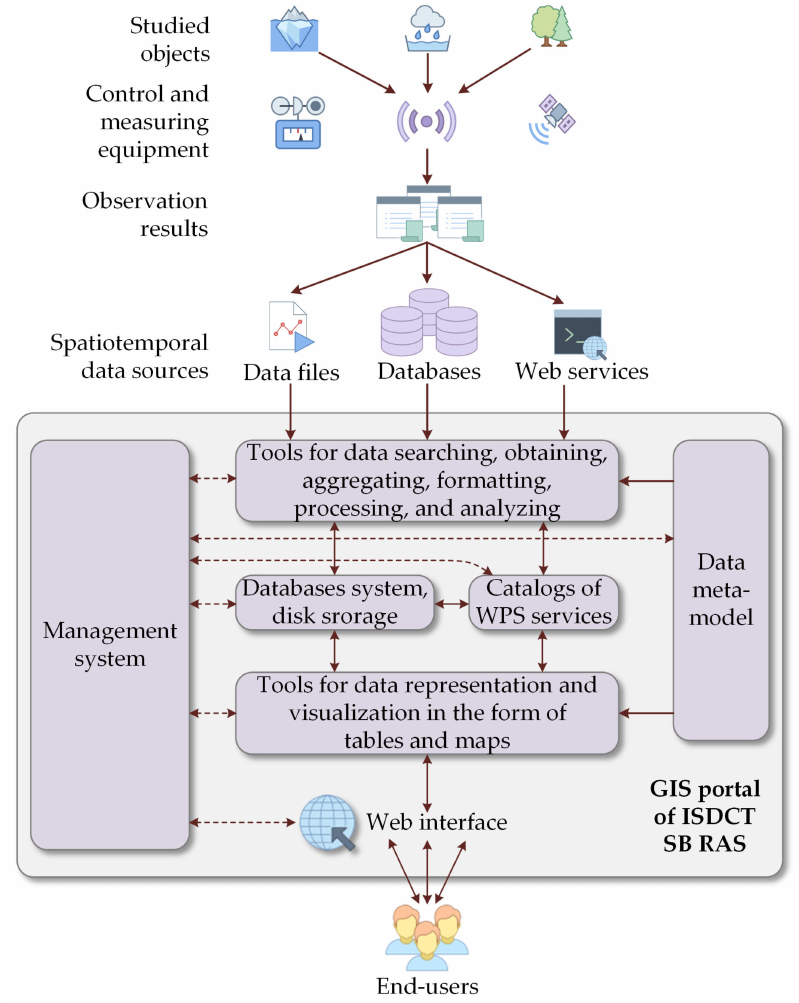
Figure 1. Scheme for operating with spatiotemporal